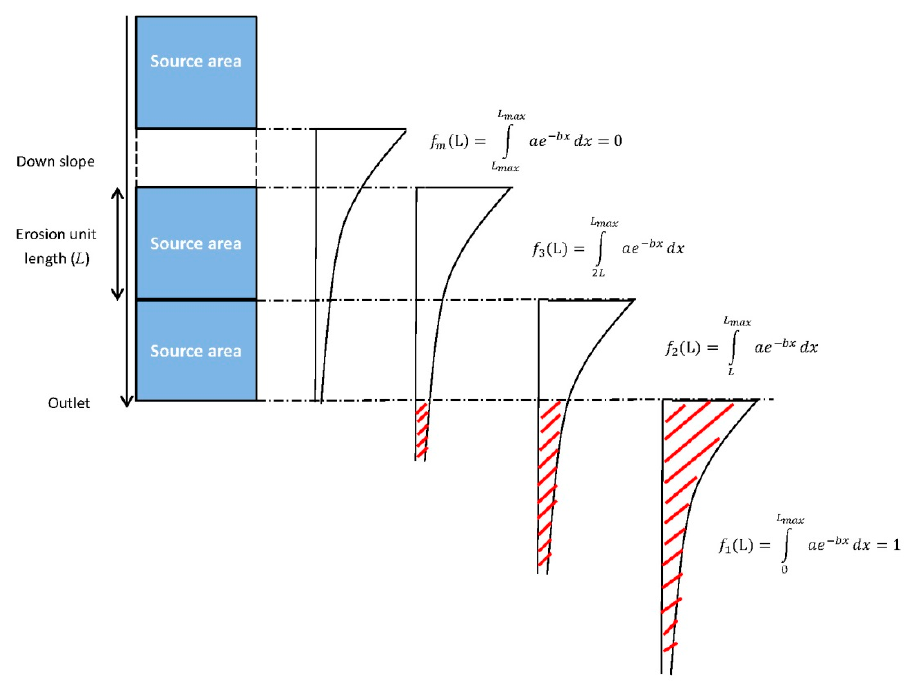
Figure 2. Conceptual use of probability density function (PDF) based on hypothesised (adapted from paper